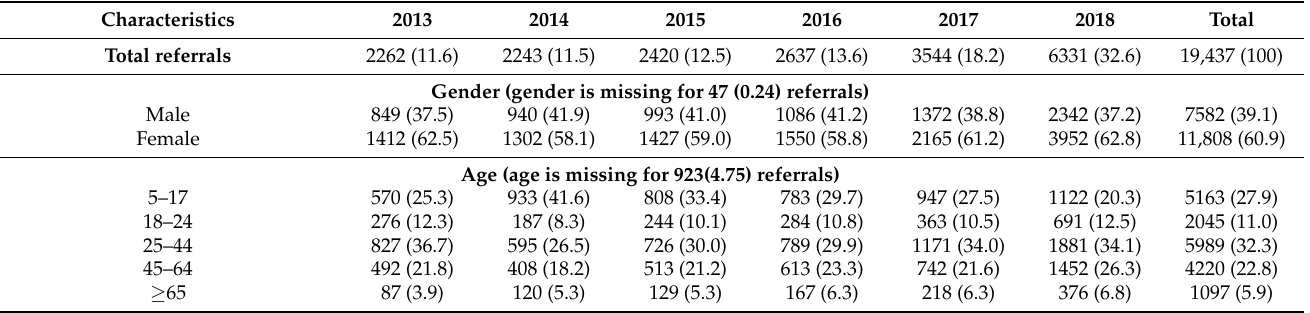
Table 1. Trends in primary mental health services and hospital-treated self-harm within 12 months of referral, Western Sydney Primary Health Network,